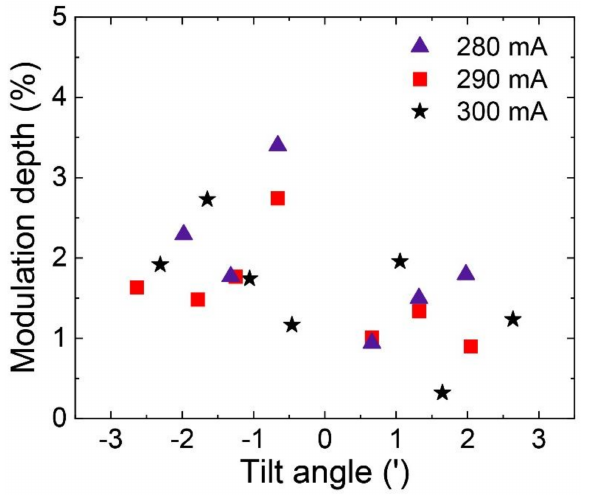
Figure 4. Modulation depth of the temporal waveform for pump currents of 280, 290, and 300 mA.